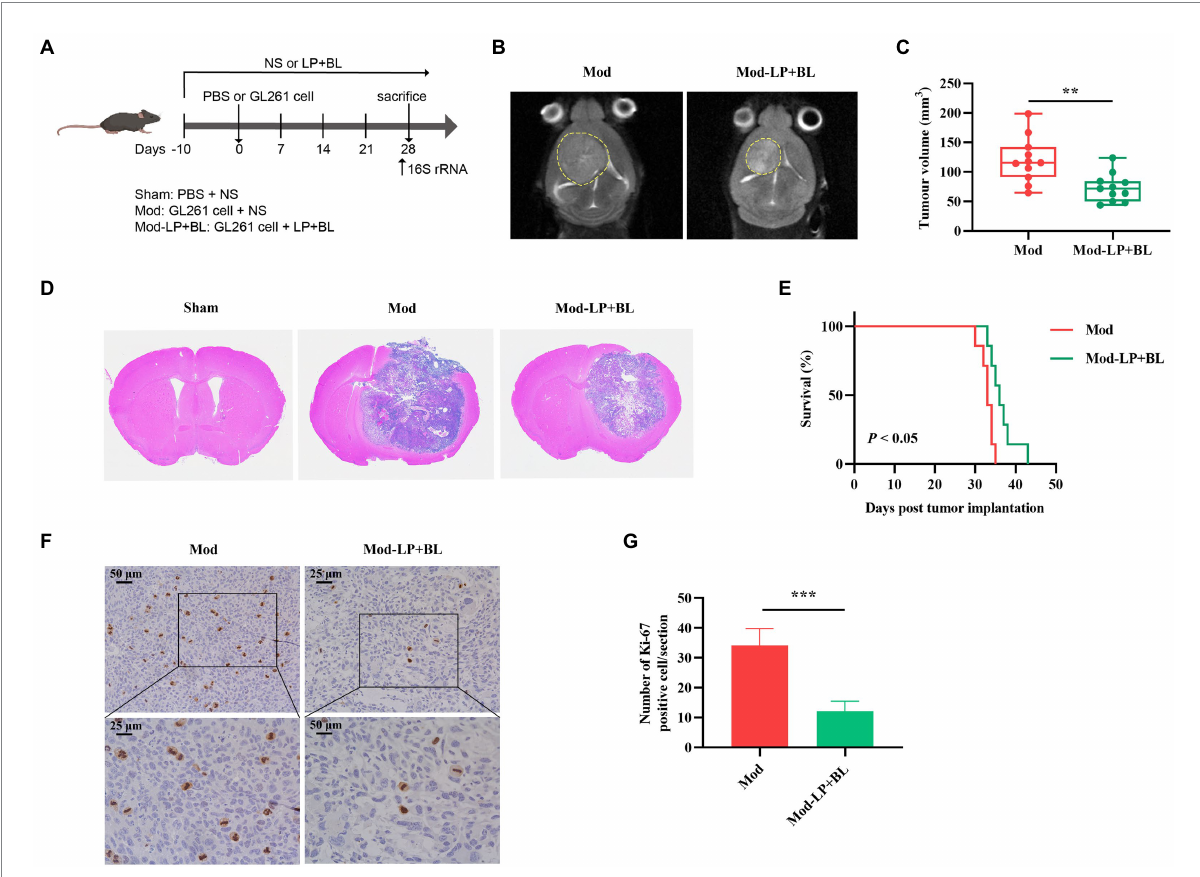
FIGURE 1 Bifidobacterium lactis and Lactobacillus plantarum inhibit glioma growth in mice. (A) Experimental design. (B) Representative T2-weighted MRI images and (C) tumor volume quantification of glioma mice receiving either PBS or probiotic combination at day 28 post tumor implantation, n = 11, two-tailed Student’s t -test. (D) Representative HE-stained coronal brain sections. (E) Kaplan–Meier survival curves, n = 7, Log-rank test. (F) Representative Ki-67-stained sections and (G) numbers of Ki-67 positive cells of brain tissues, scale bars, 50 μ m (upper) or 25 μ m (lower). n = 6. Two-tailed Student’s t -test. Mod, Model. LP, Lactobacillus plantarum ; BL, Bifidobacterium lactis ; NS, normal saline. * p < 0.05, ** p < 0.01, *** p <